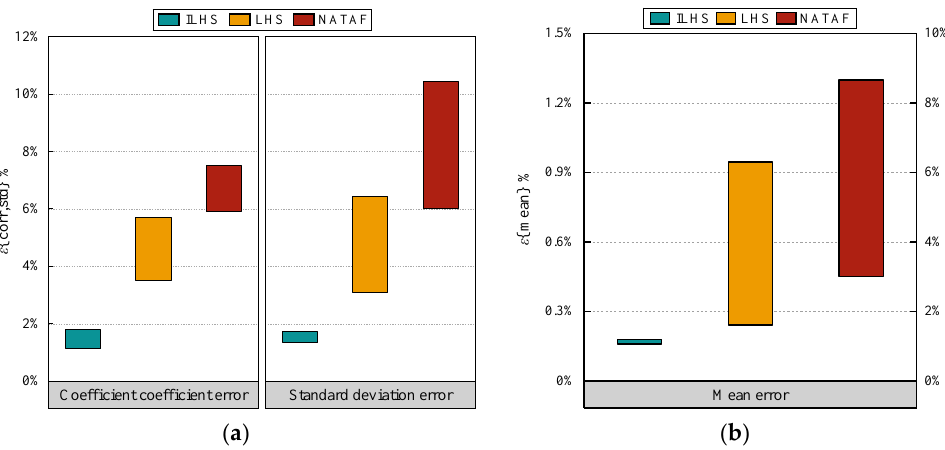
Figure 3. The error test results of the three algorithms: (a) the correlation coefficient error, standard deviation error; and (b) the mean error.